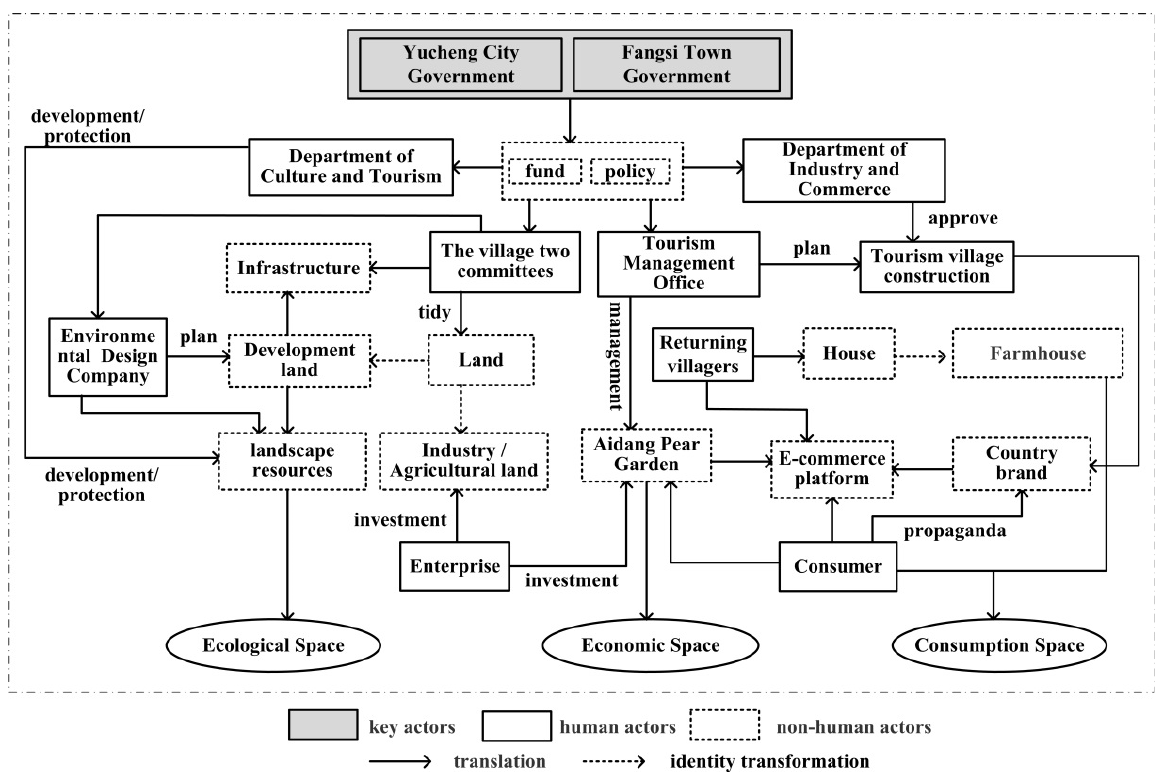
Figure 9. Action network of the original site optimization–sightseeing tourism development mode.